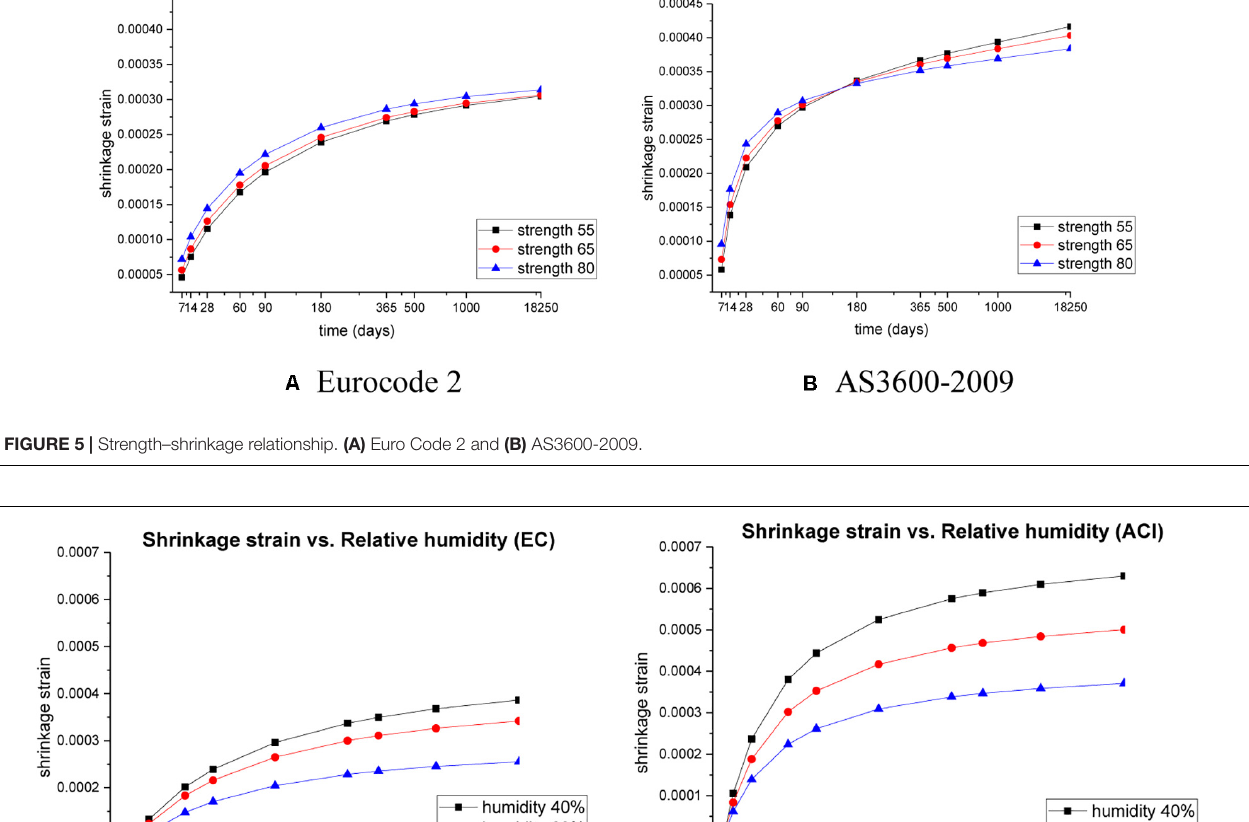
Frontiers in Built Environment |